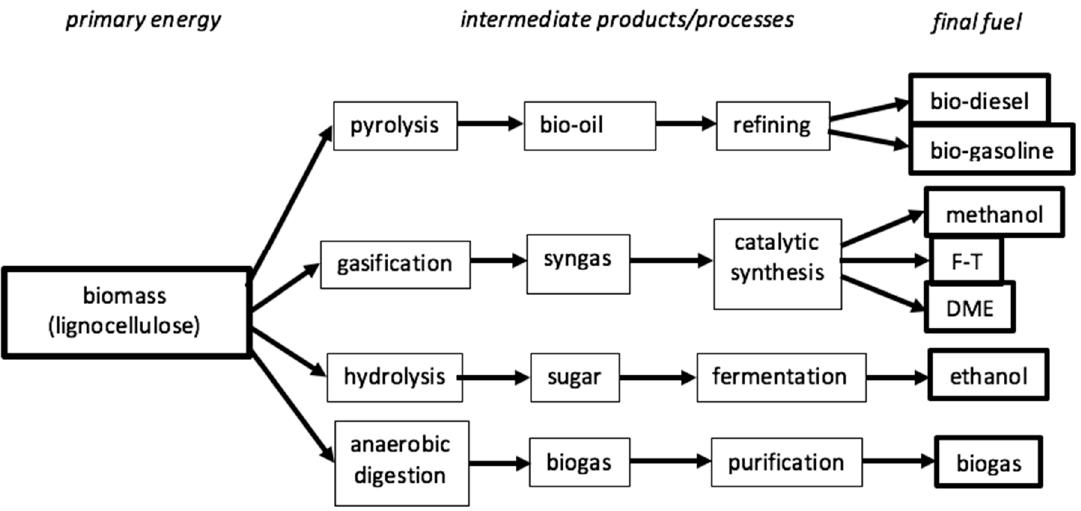
Figure 10. Various processes for the conversion of biomass into engine fuels (BTL).